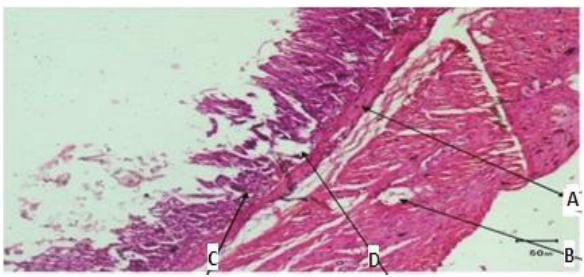
Fig-2: H &E stained slide of aspirin group showing